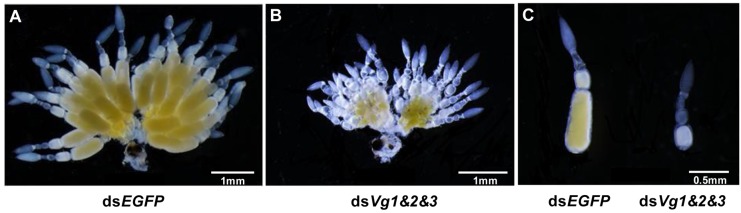
Effect of injection of dsVg1&Vg2&Vg3 on Agasicles hygrophila ovary development. (A) Image of an ovary that developed normally from an adult female injected with dsEGFP. (B) Image of an abnormal ovary from an adult injected with dsVg1&Vg2&Vg3. (C) Image of ovarioles from A, B.